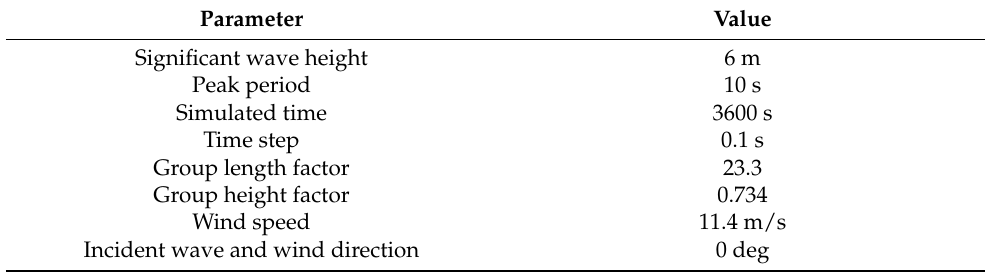
Table 3. Parameters of scenario.